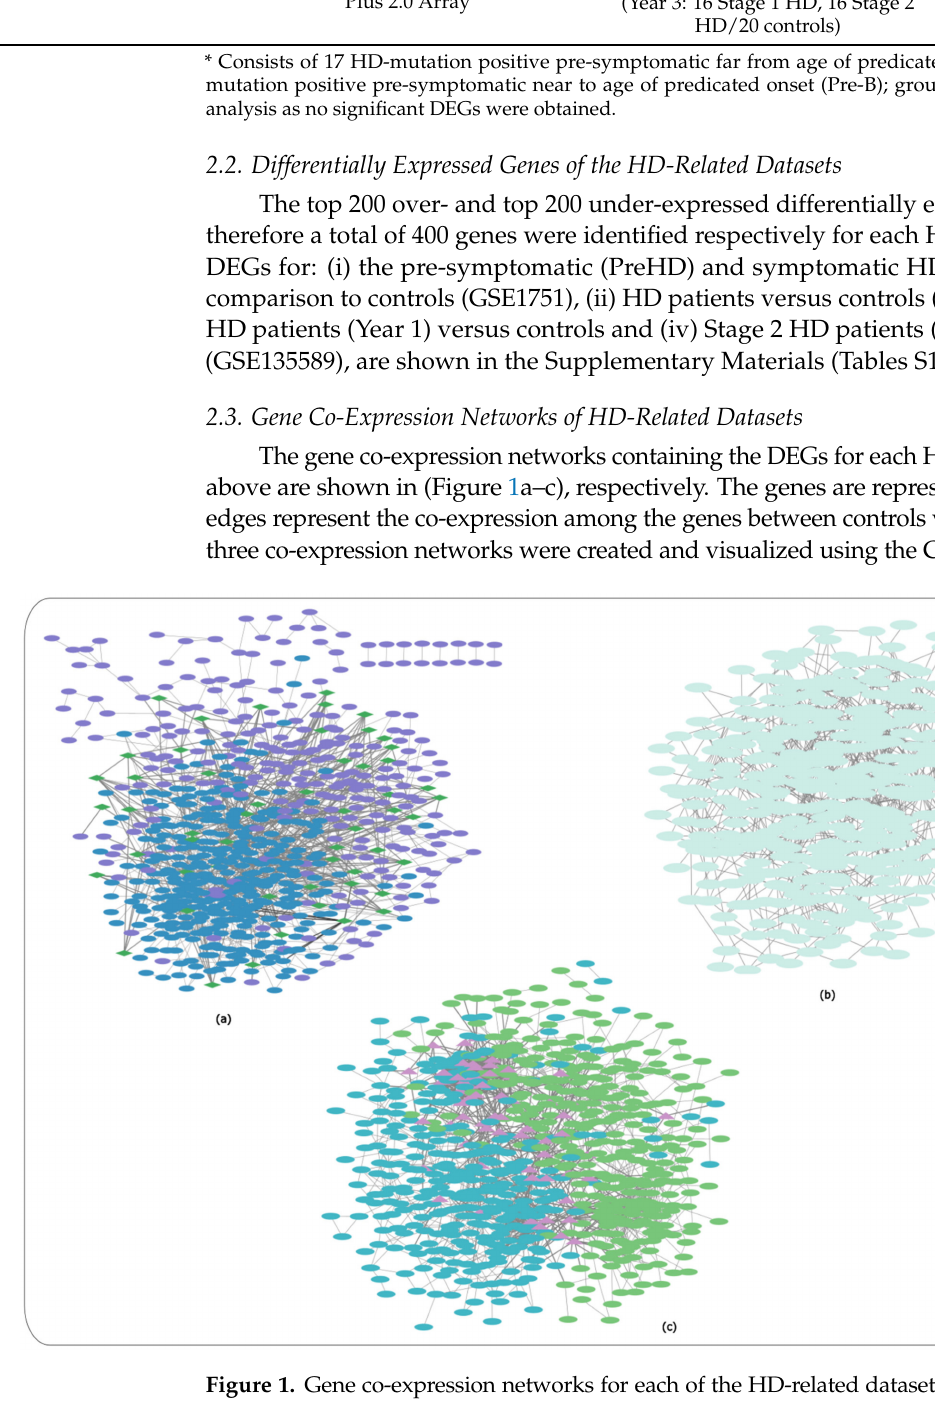
Figure 1. Gene co-expression networks for each of the HD-related datasets. ( a ) Controls versus pre- symptomatic HD patients and controls versus symptomatic HD patients, blue-coloured: genes